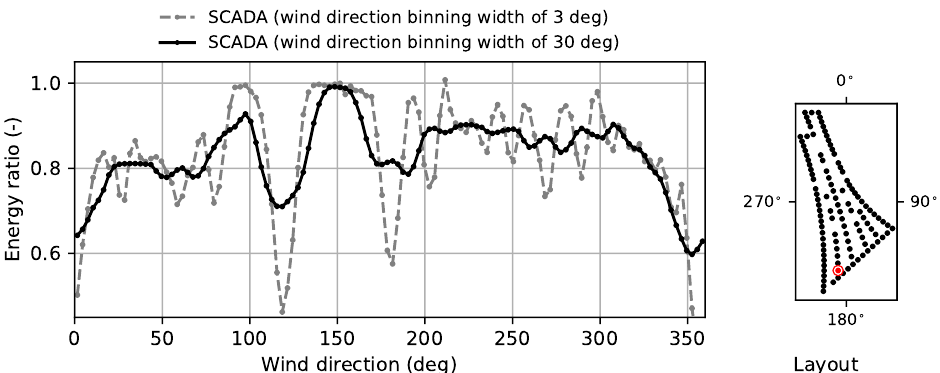
Figure 4. The effect of different bin widths (3 ◦ vs. 30 ◦ ) on the energy ratio curves for test Turbine 32 of the Anholt wind farm. The reference turbines are all upstream turbines within a 5 km radius, and the reference wind direction is the measured wind direction at Turbines 30 and 31. The energy ratios are calculated every 3 ◦ . Wider bins provide more overlap and smoother wake profiles (e.g., near 145 ◦ ). Yet wider bins also blend out wake profiles otherwise observed in the data (e.g., between 200 ◦ and 300 ◦ ). The layout schematic on the right shows the location of Turbine 32 in the wind